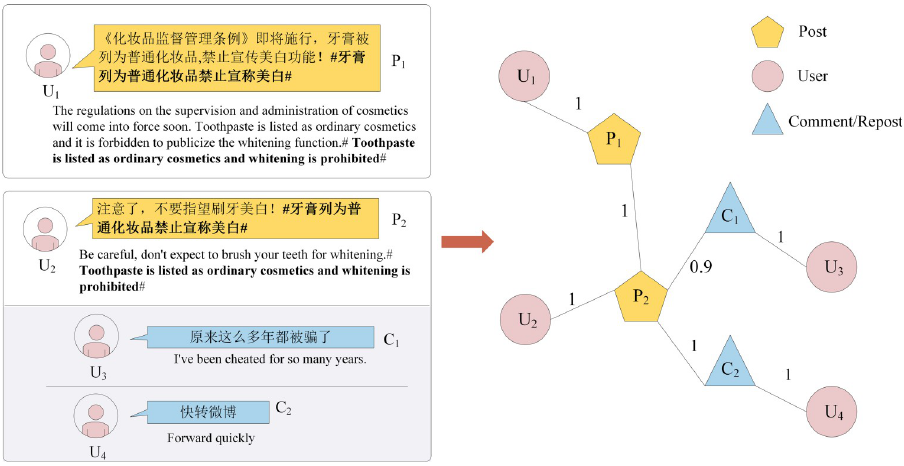
Fig 1. The heterogeneous graph of a